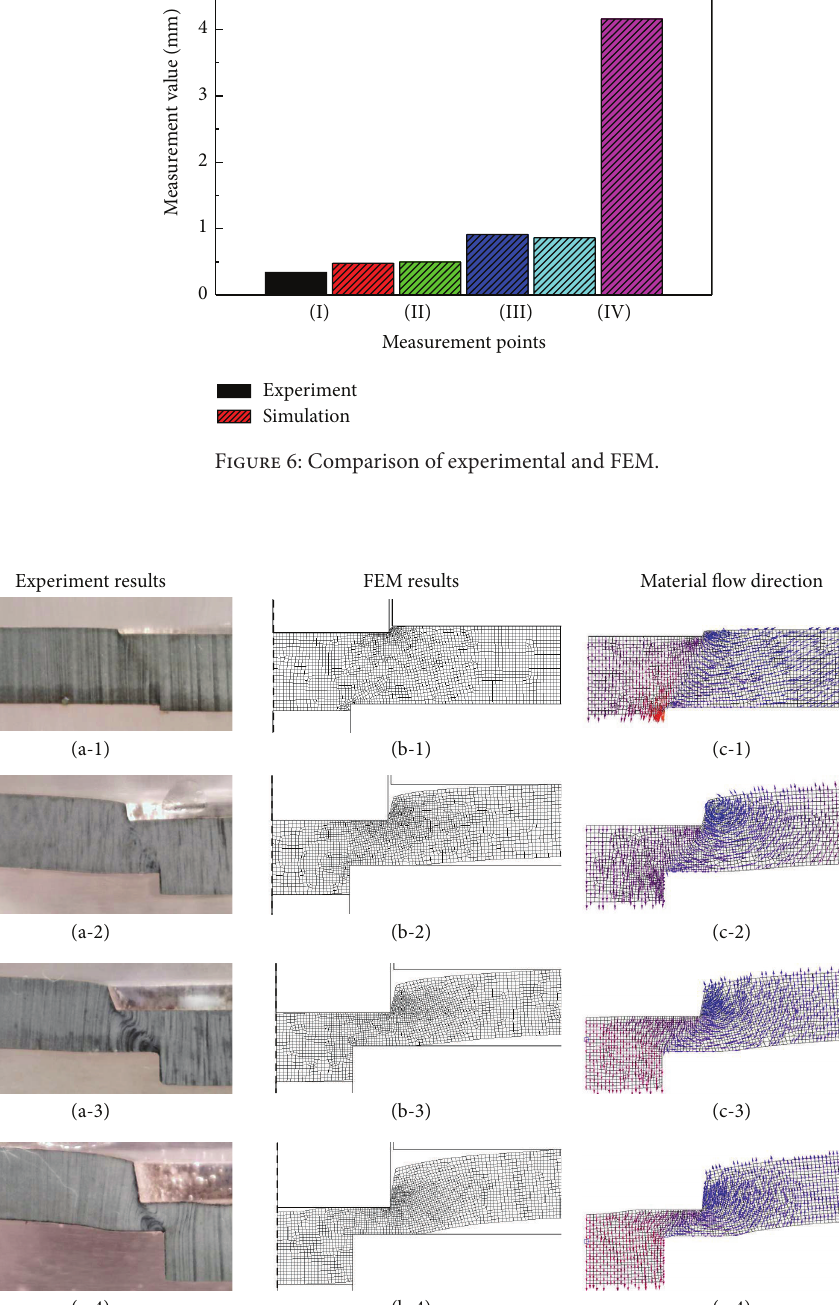
defects become visible around the extrusion cavity: extrusion shrinkage was caused by the extrusion rod and blank buckling was caused by the punch’s